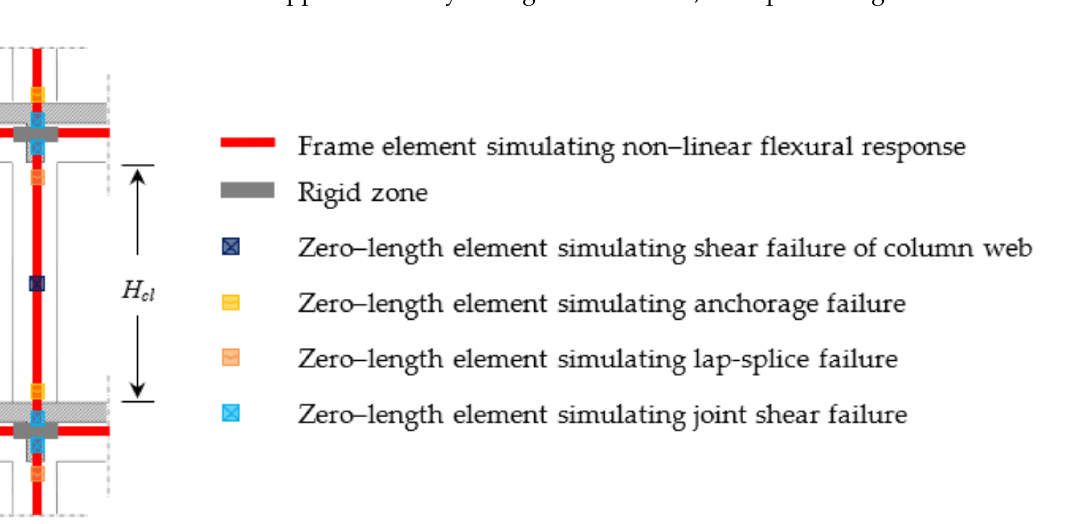
Figure 1. Simulation of strength mechanisms that develop within the structural system of substandard R/C buildings. Hatched regions represent cross-sections of members extending normal to the plane of view (e.g., slab and transverse